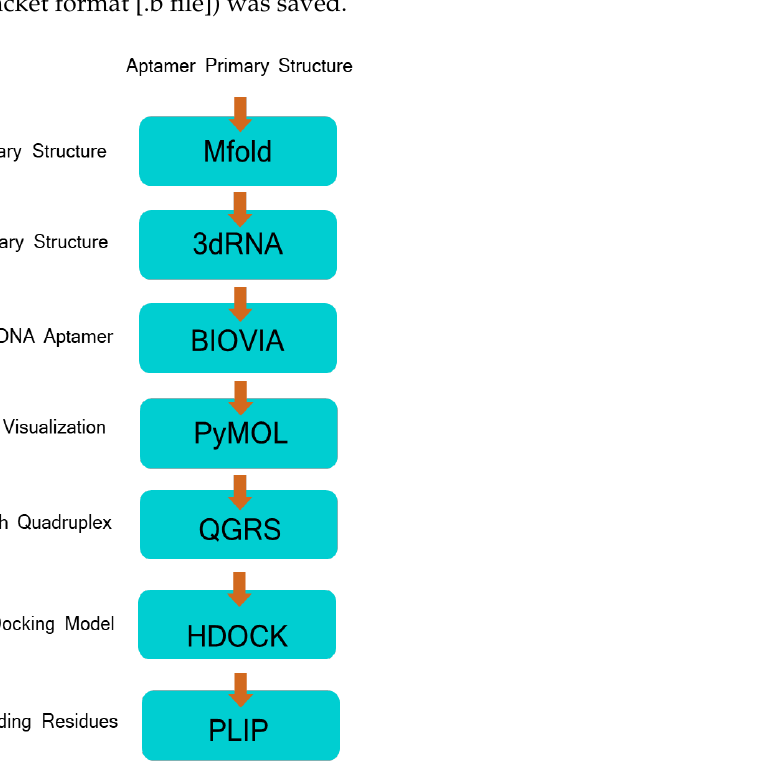
Figure 1. Bioinformatics pipeline to predict the 3D structure of aptamers and the docking model, including the identification of significant interactions on aptamer – protein target complexes.